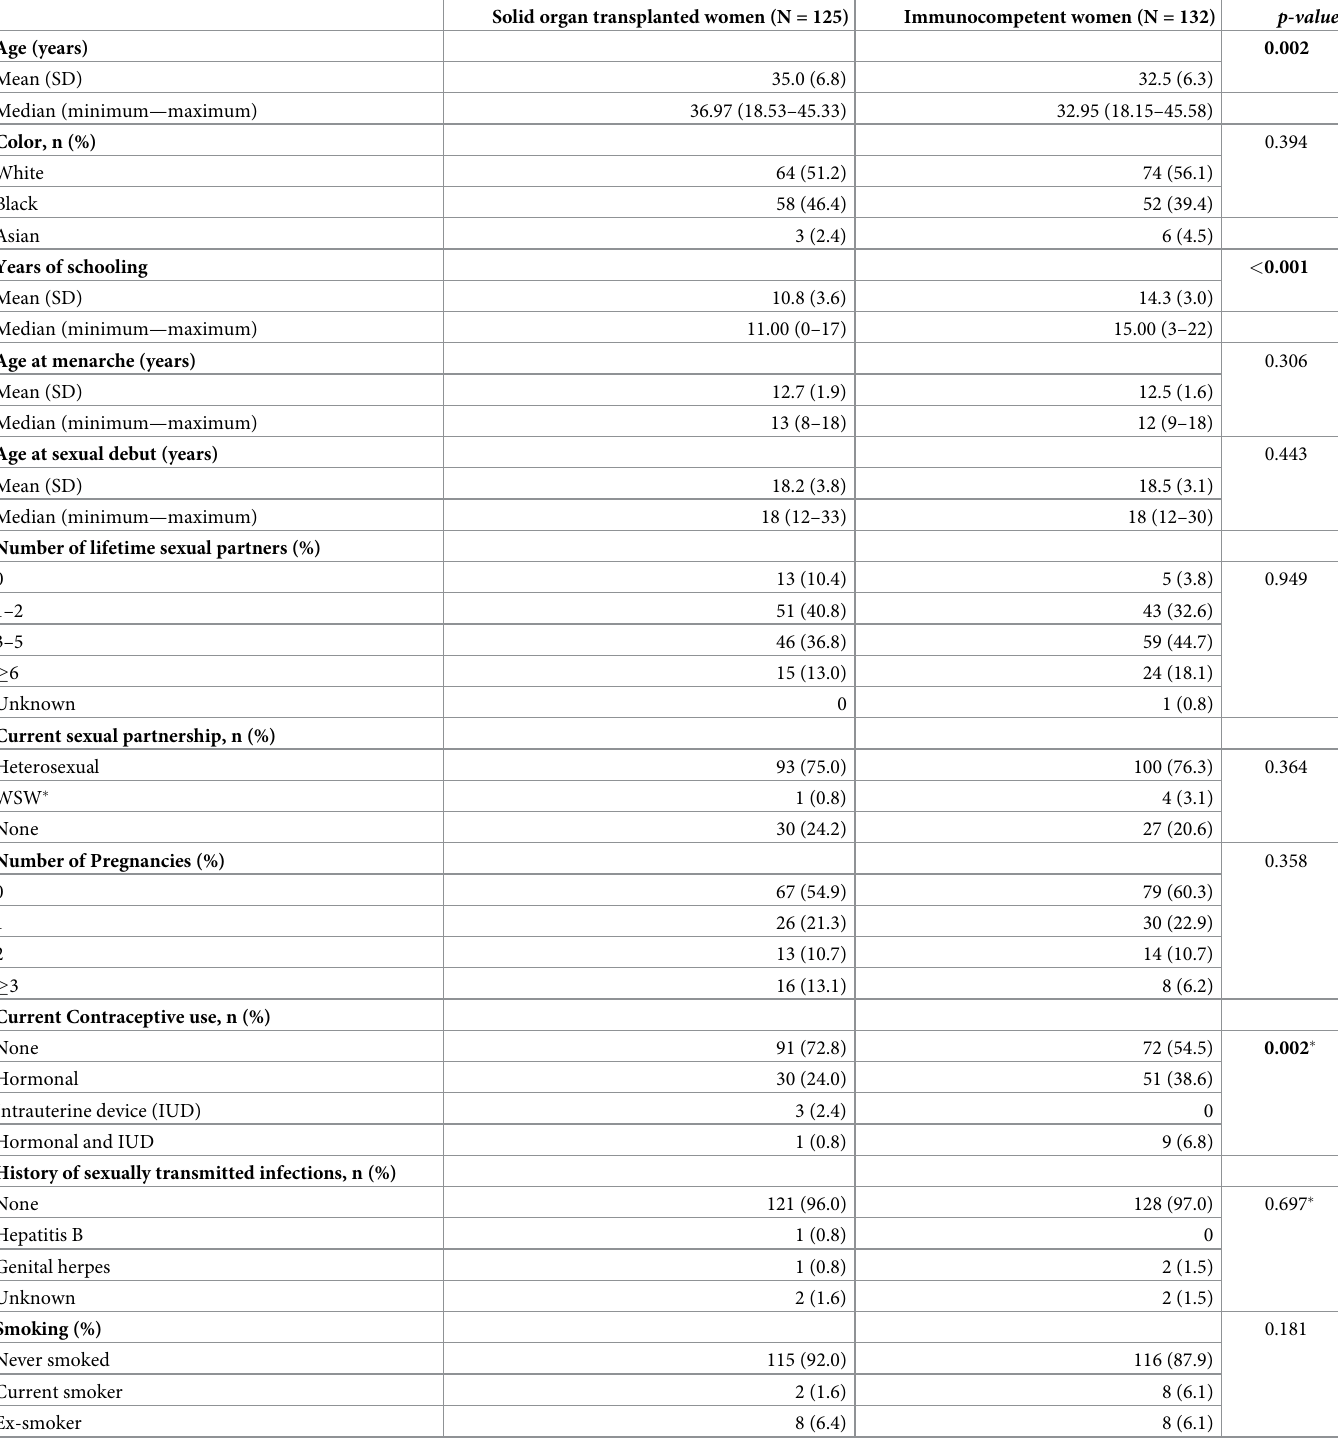
Table 1. Demographic and clinical characteristics of the study